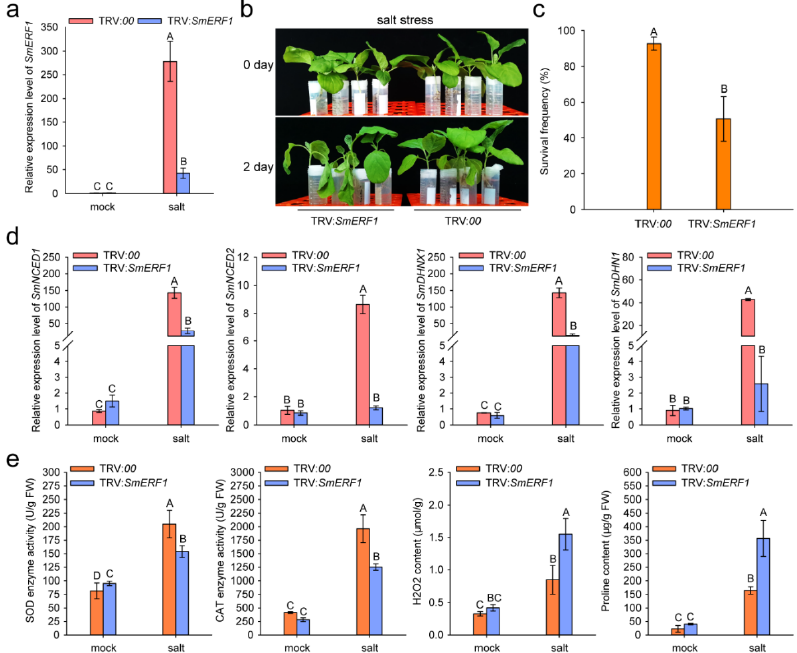
Figure 7. Effects of SmERF1 silencing on eggplant responses to salt stress (TRV: SmERF1 , SmERF1 - silenced; TRV: 00 , control). ( a ) Silencing efficiency of SmERF1 in plants under a salt stress base on a qPCR assay. ( b ) Phenotype of SmERF1 -silenced and control plants challenged with salt stress at 2